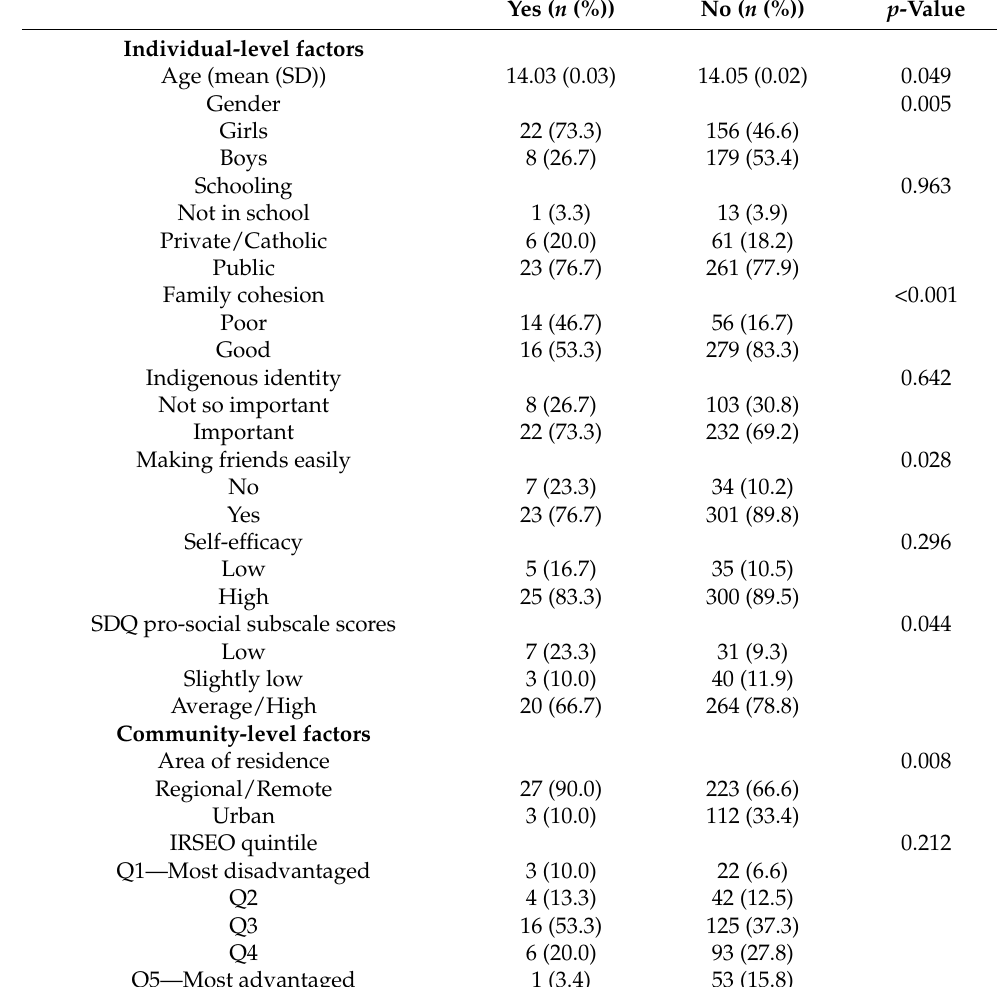
Table 3. Factors associated with self-harm (bivariate analysis).